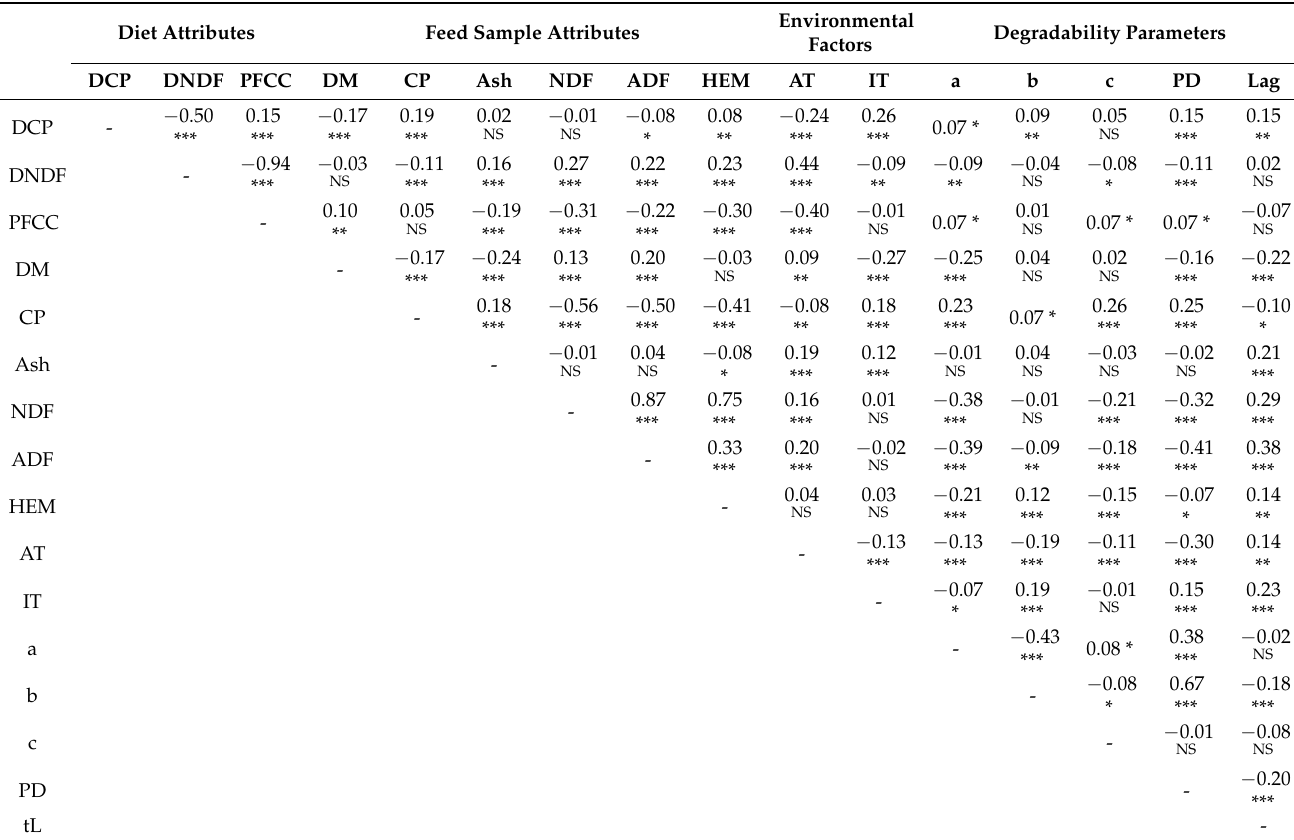
Table 2. Pearson correlations between diet, feed and climatic factors affecting degradation of feeds in the rumen. Diet Attributes Feed Sample Attributes